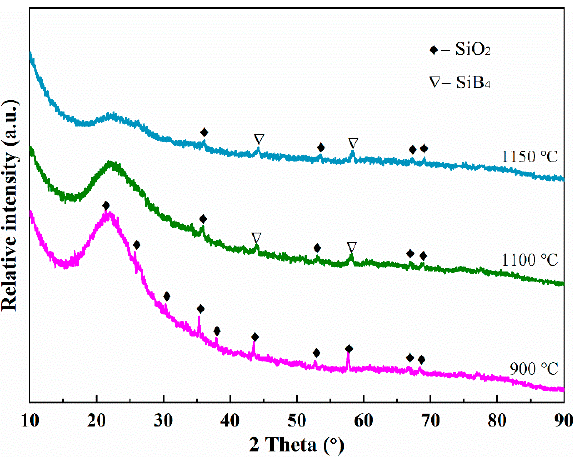
Figure 7. XRD patterns of the samples with heating rate of 3 °C/min.